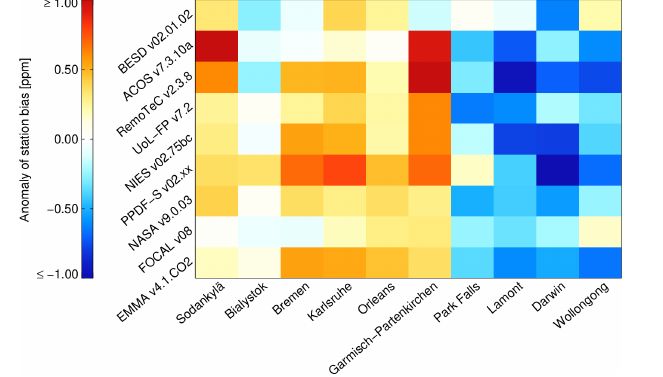
Figure 12. Average XCO 2 differences (satellite – TCCON) for the different satellite XCO 2 products at 10 TCCON sites as used by the EMMA assessment method. The differences are shown as anoma- lies; i.e., the sum of the values corresponding to a given row is zero. Note that here “ACOS” refers to NASA’s ACOS algorithm as ap- plied to GOSAT and that “NASA” refers to NASA’s ACOS algo- rithm as applied to OCO-2.